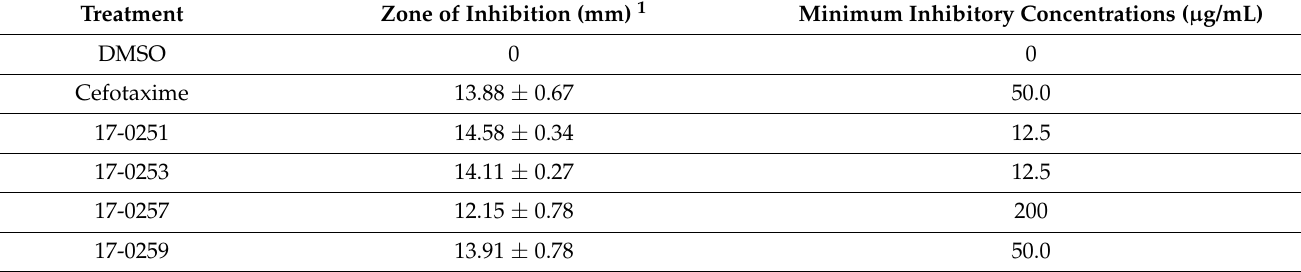
Table 2. In vitro antibacterial activity of the fungal crude extracts against Aac , JT-0003 in disc diffusion assay and MICs by microdilution